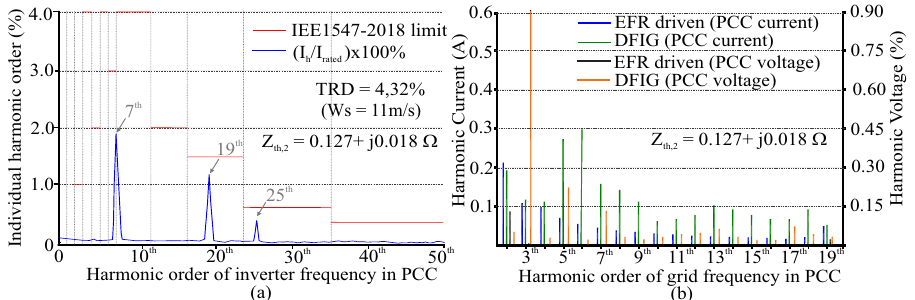
Figure 7. ( a ) Individual harmonic order without the fundamental grid component (60 Hz). ( b ) In- dividual current and voltage harmonics comparison with DFIG considering the harmonics of the fundamental grid frequency (60 Hz).